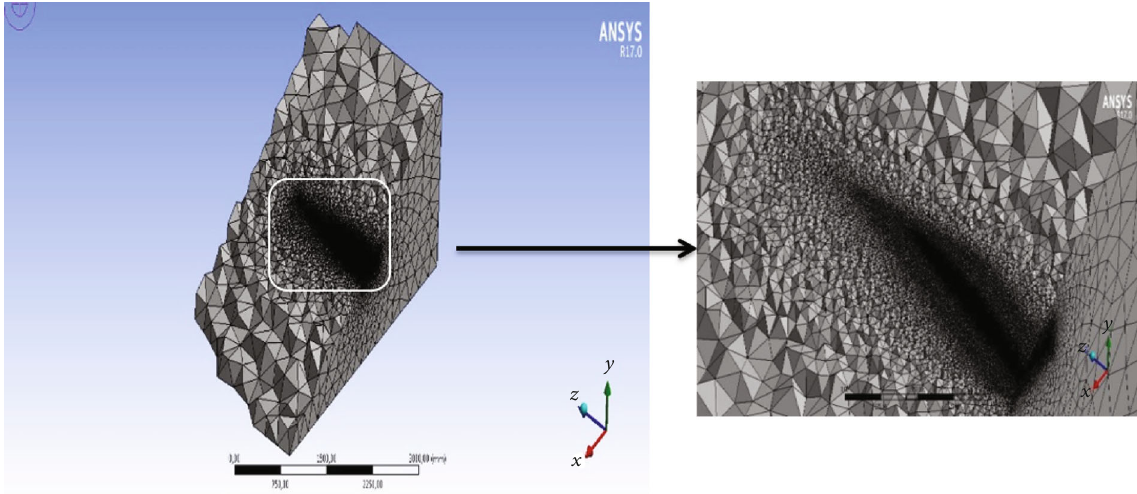
Figure 13: Mesh of the domain of the fl uid and a zoom of the area of